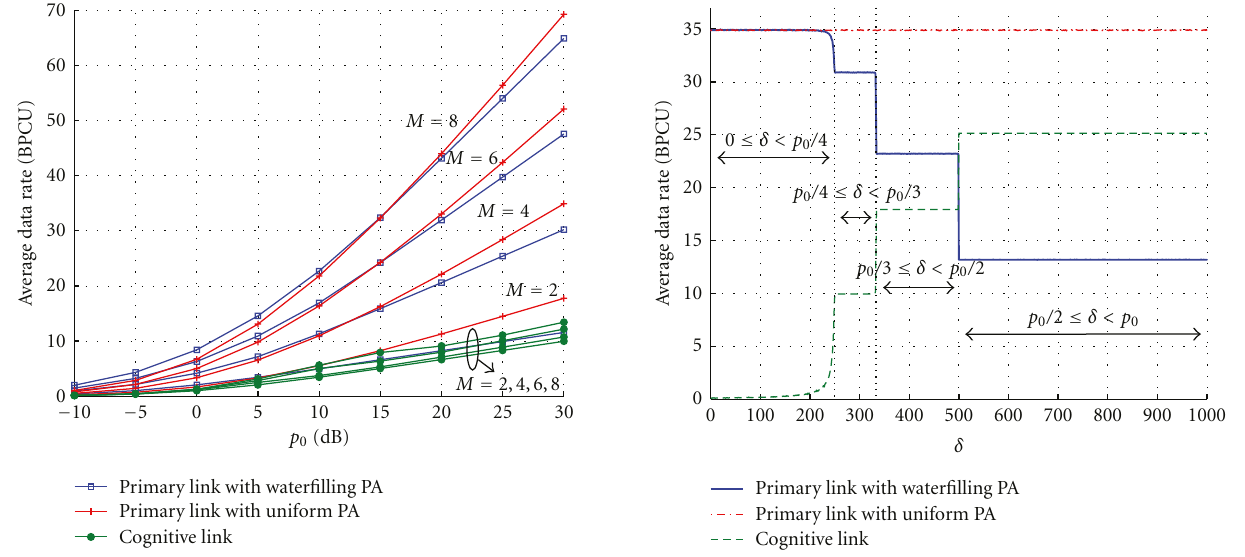
Figure 5: Average data rate for both the primary and the secondary networks versus the power allocation level δ (linear scale); M = 4, and p 0 = 30